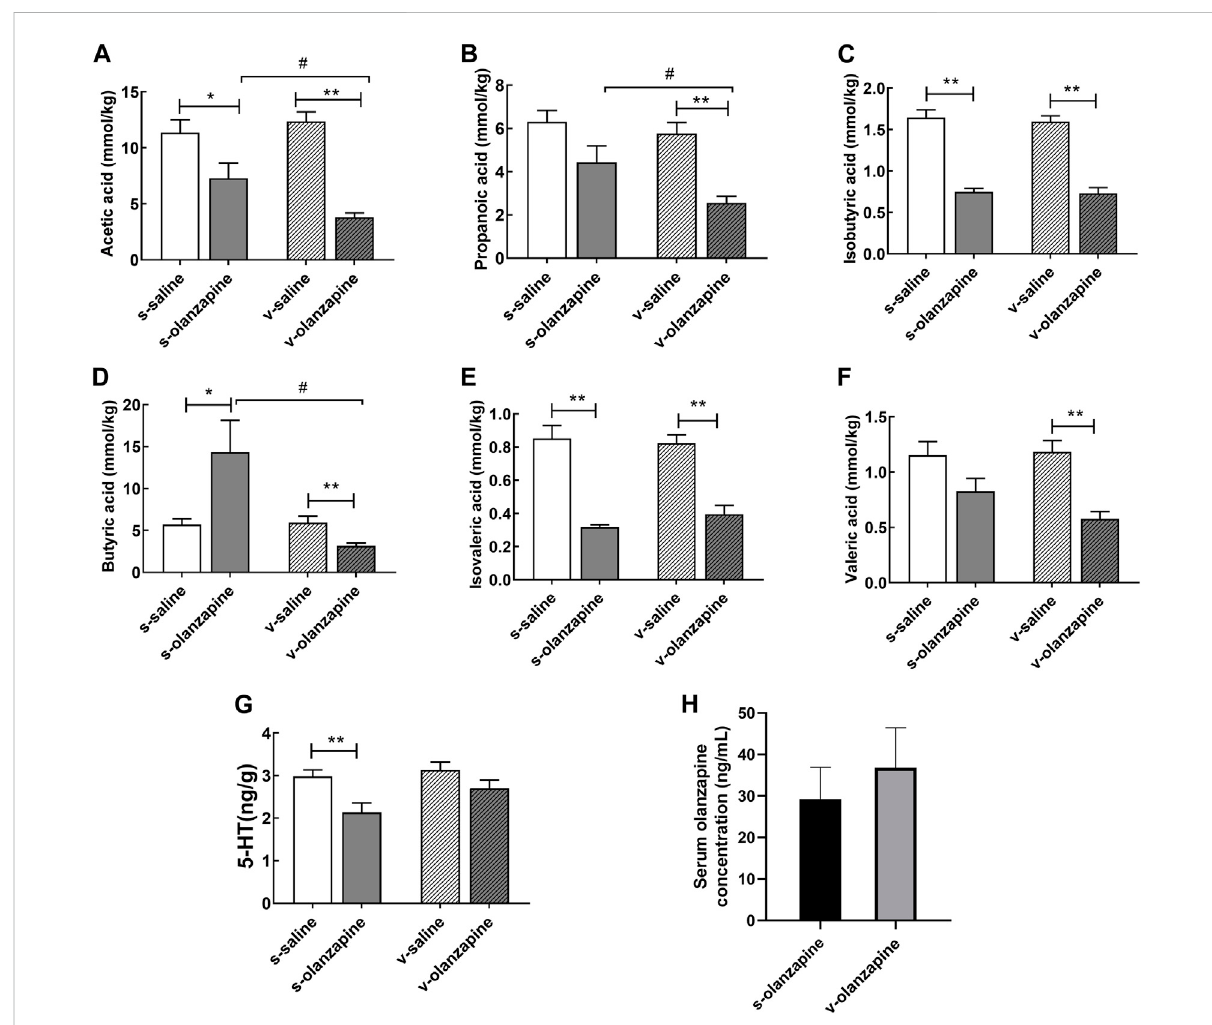
FIGURE 5 Theconcentrationsofaceticacid (A) ,propionicacid (B) ,isobutyricacid (C) ,butyricacid (D) ,isovalericacid (E) ,valericacid (F) and5-HT (G) inthe cecal contents among the four groups, and serum levels of olanzapine (H) between sham and vagotomy conditions, are depicted. * p < 0.05; ** p < 0.01, # p < 0.05 and ## p <